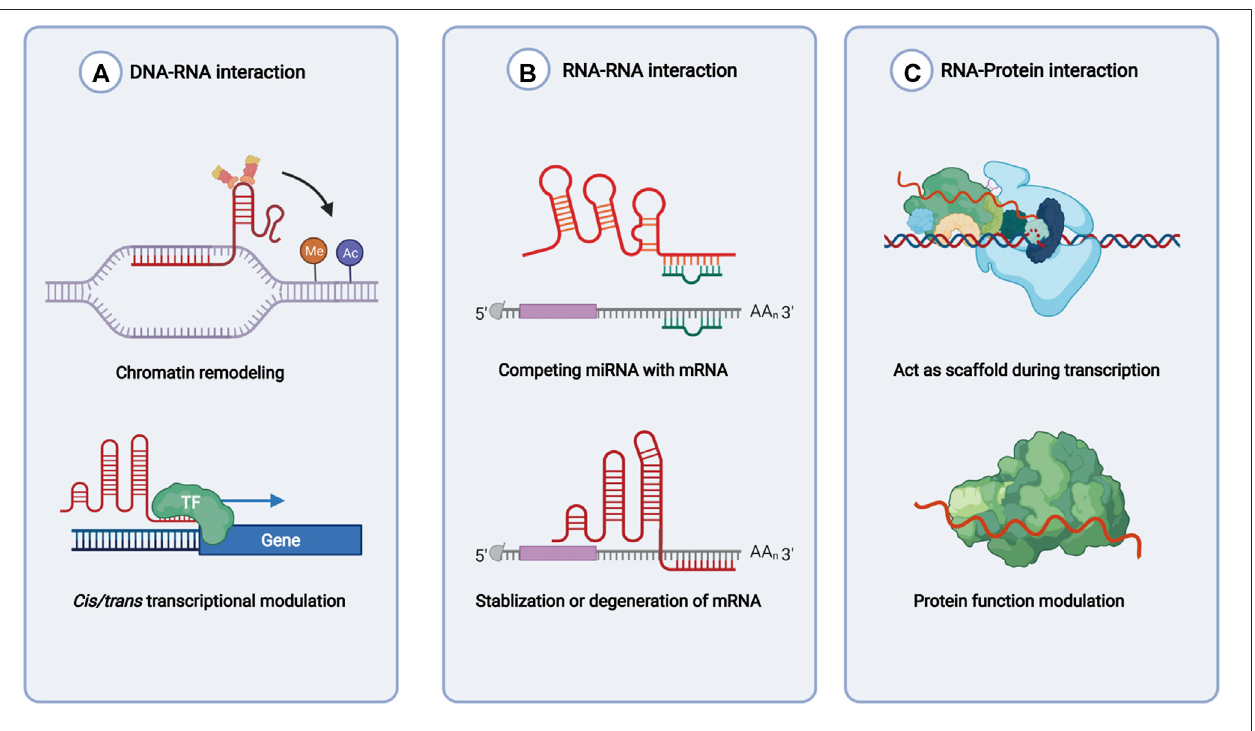
FIGURE 1 | Functions of lncRNAs based on molecules interacted with. (A) lncRNAs recruit enzymes and transcription factors to involve in chromatin remodeling and transcription initiation. (B) lncRNAs regulate mRNA stability directly or indirectly. (C) lncRNAs bind with RNA binding protein and help with functions of the latter.